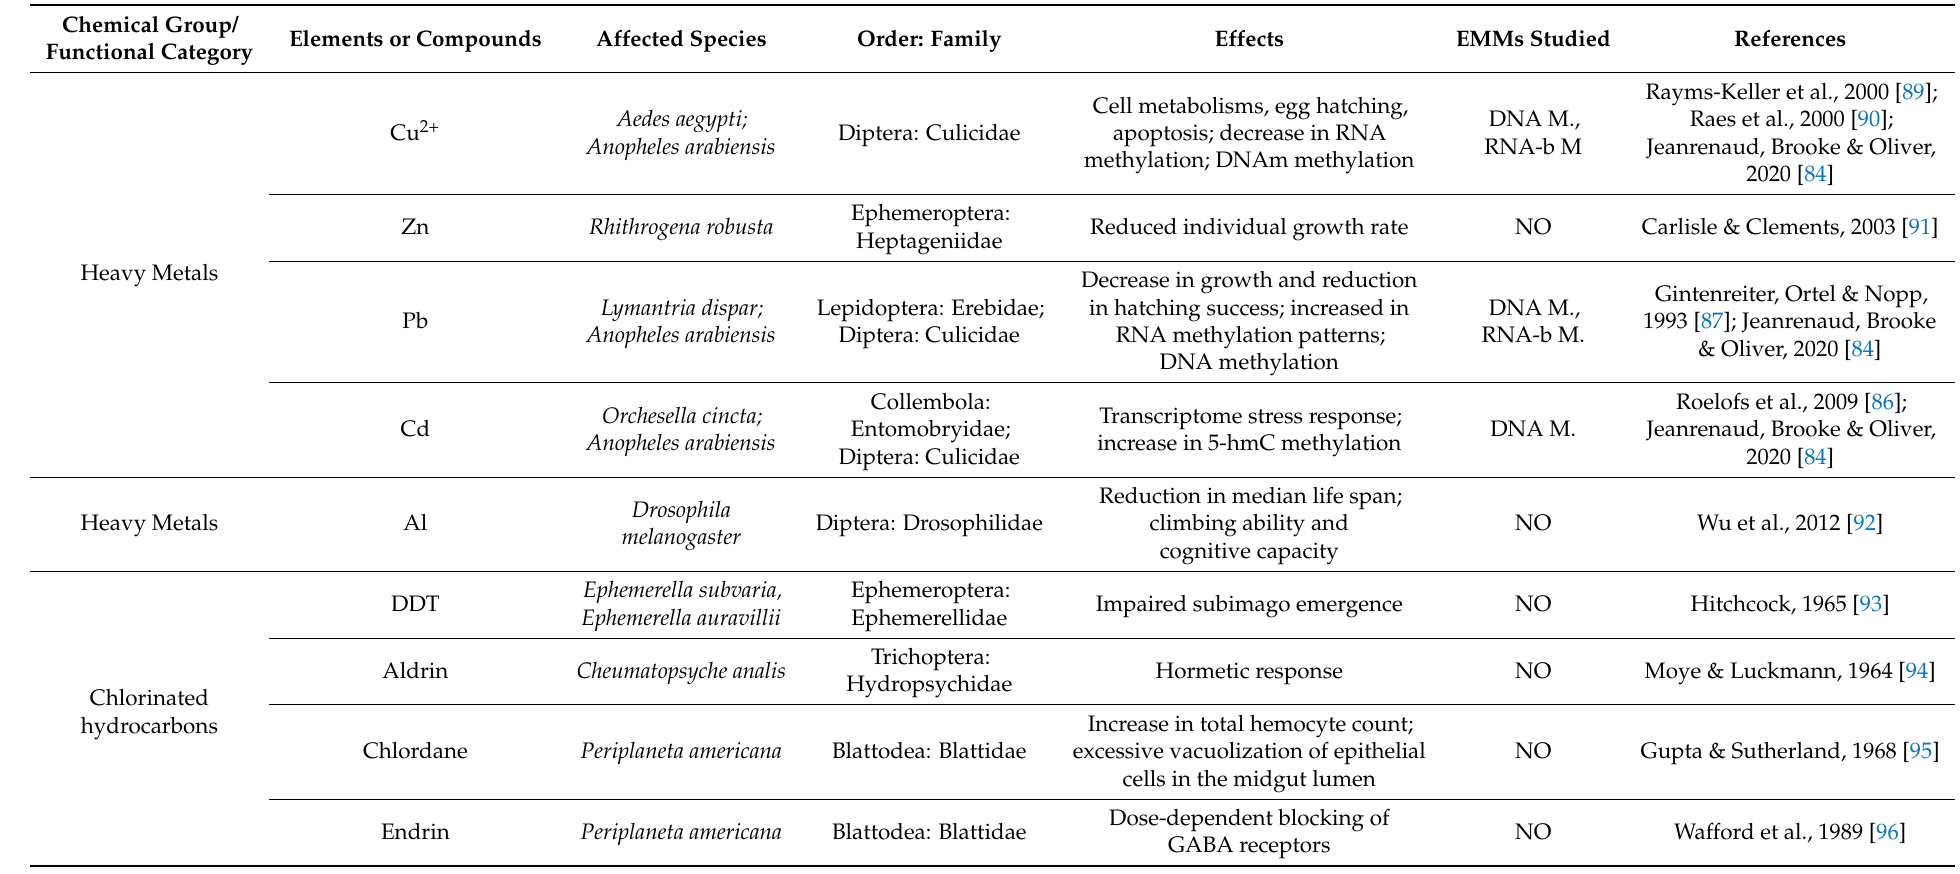
Table 2. Responses of insects to different toxicants. The first column indicates the kind of chemical compound described; the second indicates the compound. The third lists the affected species. The fourth column indicates the order and family of the insect. The fifth lists the effects observed in response to the toxicant. The sixth shows the epigenetic molecular mechanisms involved, where “DNA M.” refers to C5-cytosine methylation, “H. M.” stands for histone modifications, and “RNA-b M.” is RNA-based mechanisms [54]. The seventh column has the corresponding references